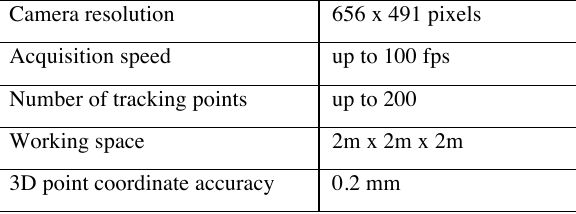
Table 3. Technical characteristics of the motion capture